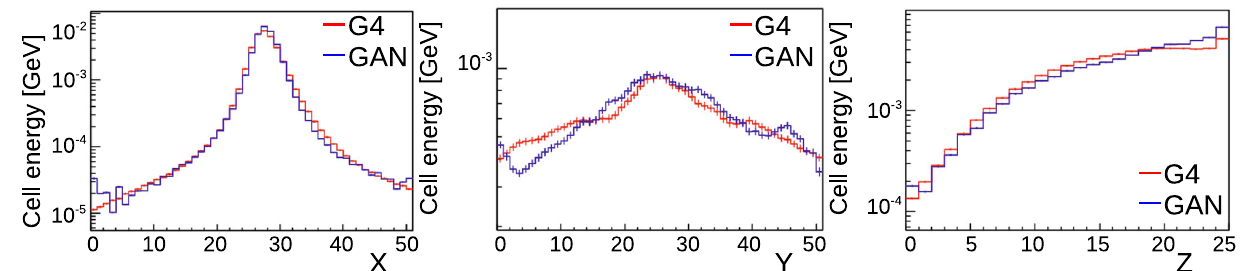
Fig. 15 Shower Shapes for GEANT4 vs. GAN charged pion events along X (left), Y (mid) and Z (right) axes with random E P and θ